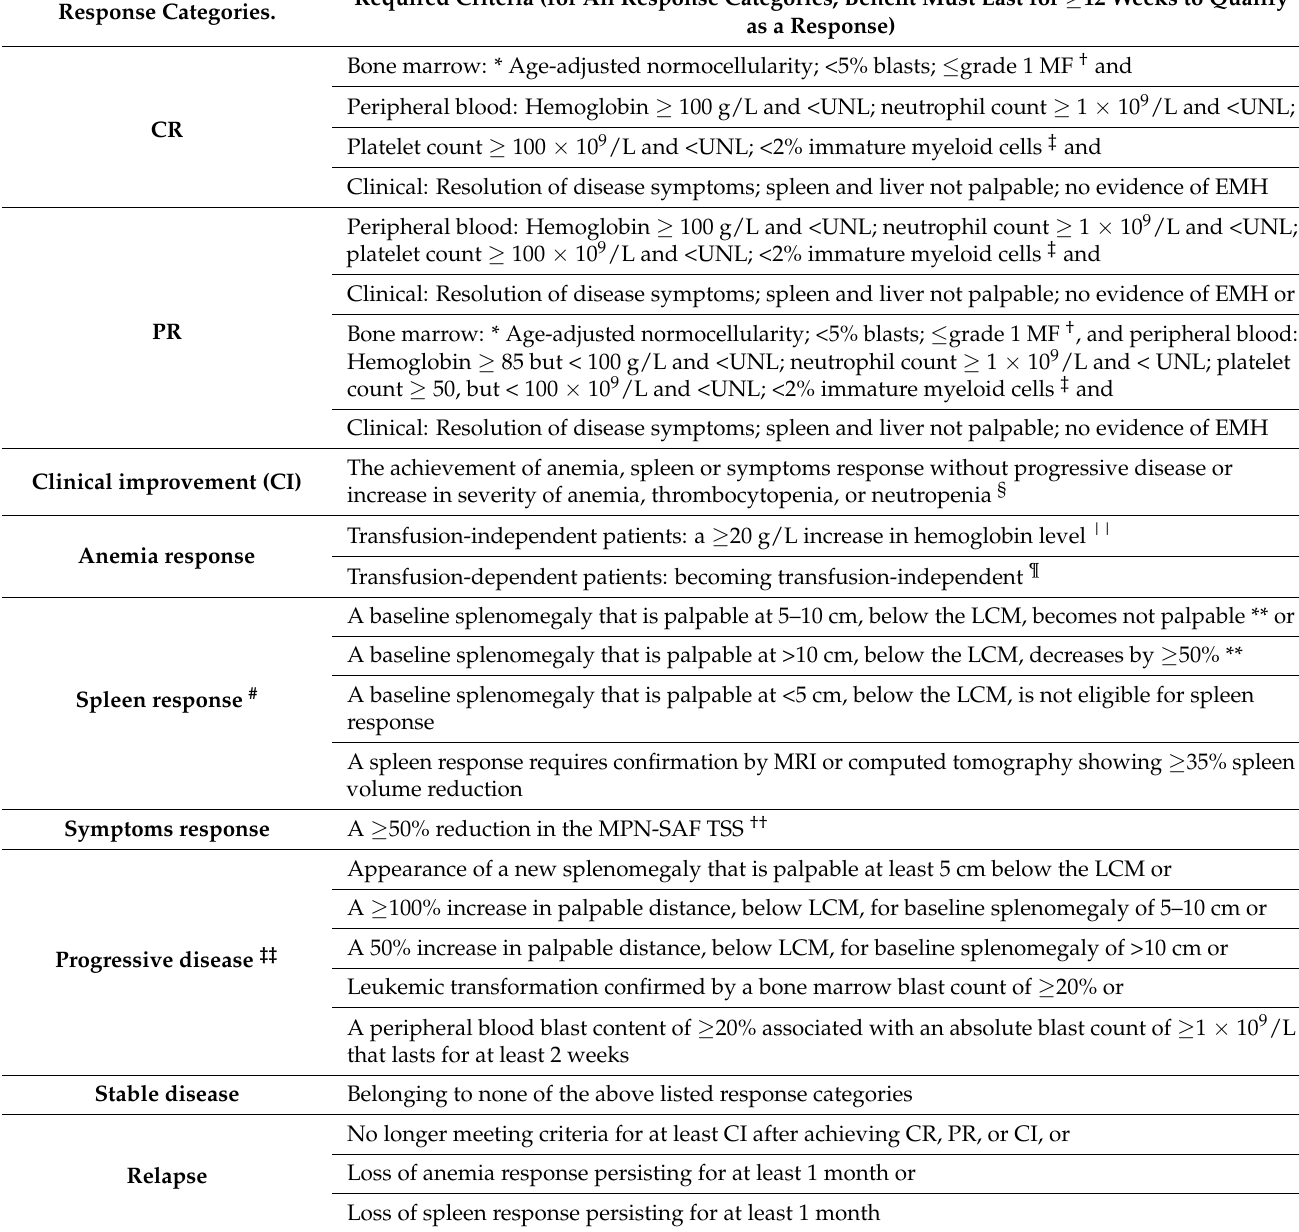
Table 2. International Working Group for Myelofibrosis Research and Treatment and European LeukemiaNet (IWG-ELN) Response Criteria for